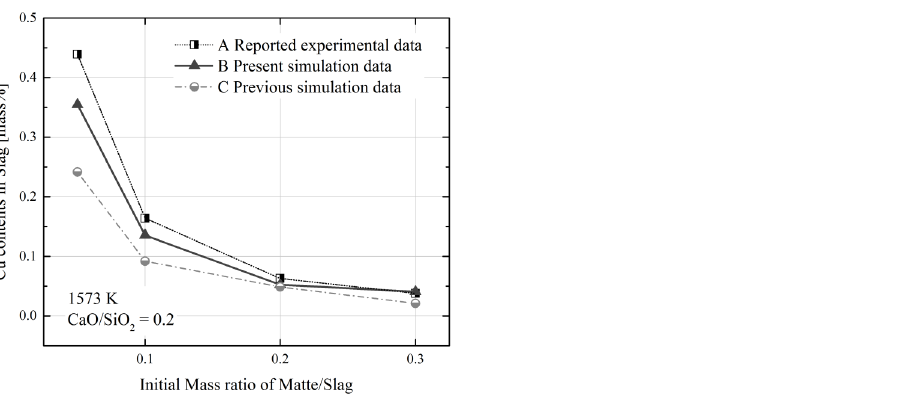
Figure 9. Simulation results and experimental data comparing the copper content of slag with a FeS input to matte at 1573 K. Table 5. Simulation conditions of slag and matte for comparison with reported experimental data. Calc. No.